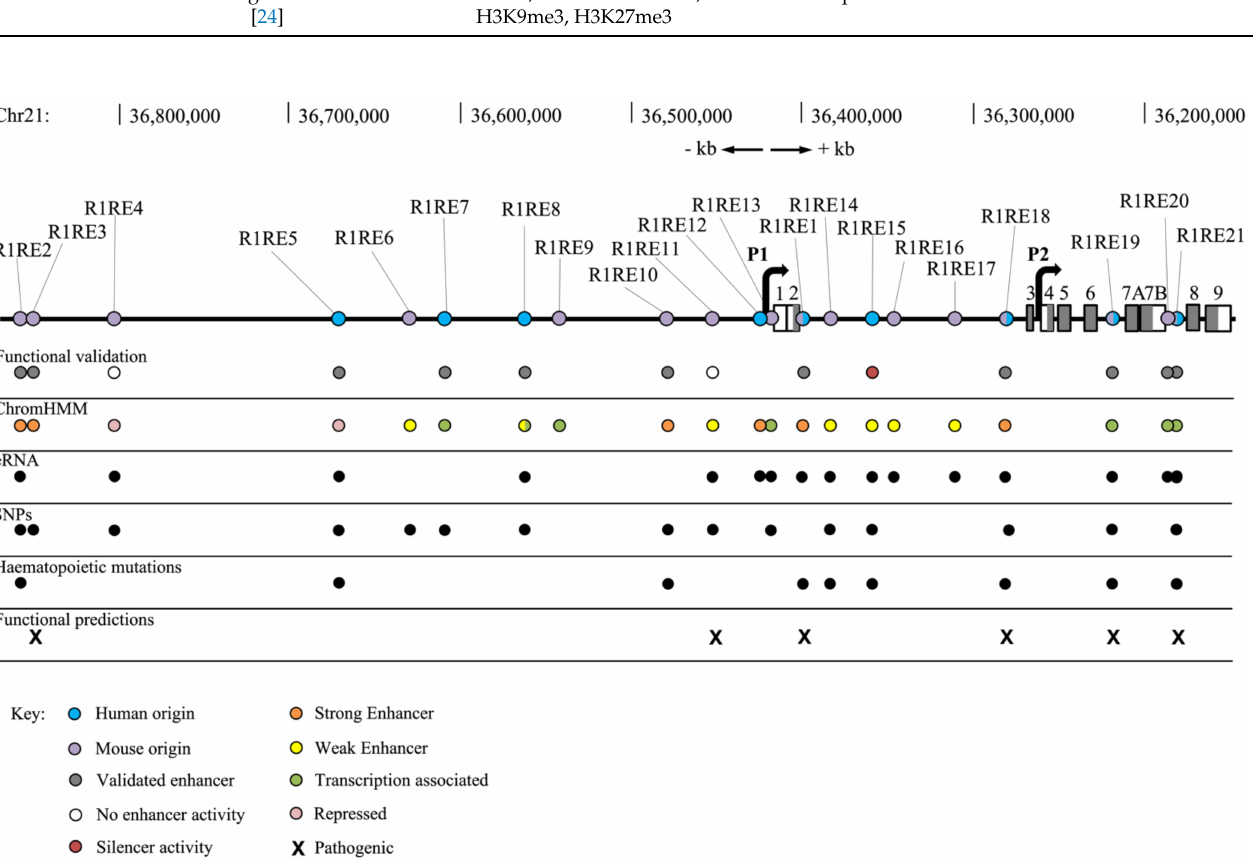
Figure 2. Schematic overview of human RUNX1 locus and annotations (chromosome 21: 36,148,773-36,872,777). Each RE with human origin is annotated with blue circles, REs with mouse origin are annotated with purple circles, grey boxes annotate exons. The two RUNX1 promoters are represented by black right angled arrows. R1REs are annotated with their functional validation, ChromHMM characterisation, ability to produce eRNA, SNP status, functional predictions and whether they harbour mutations present in haematopoietic patients. Key for ChromHMM is in the bottom left of the